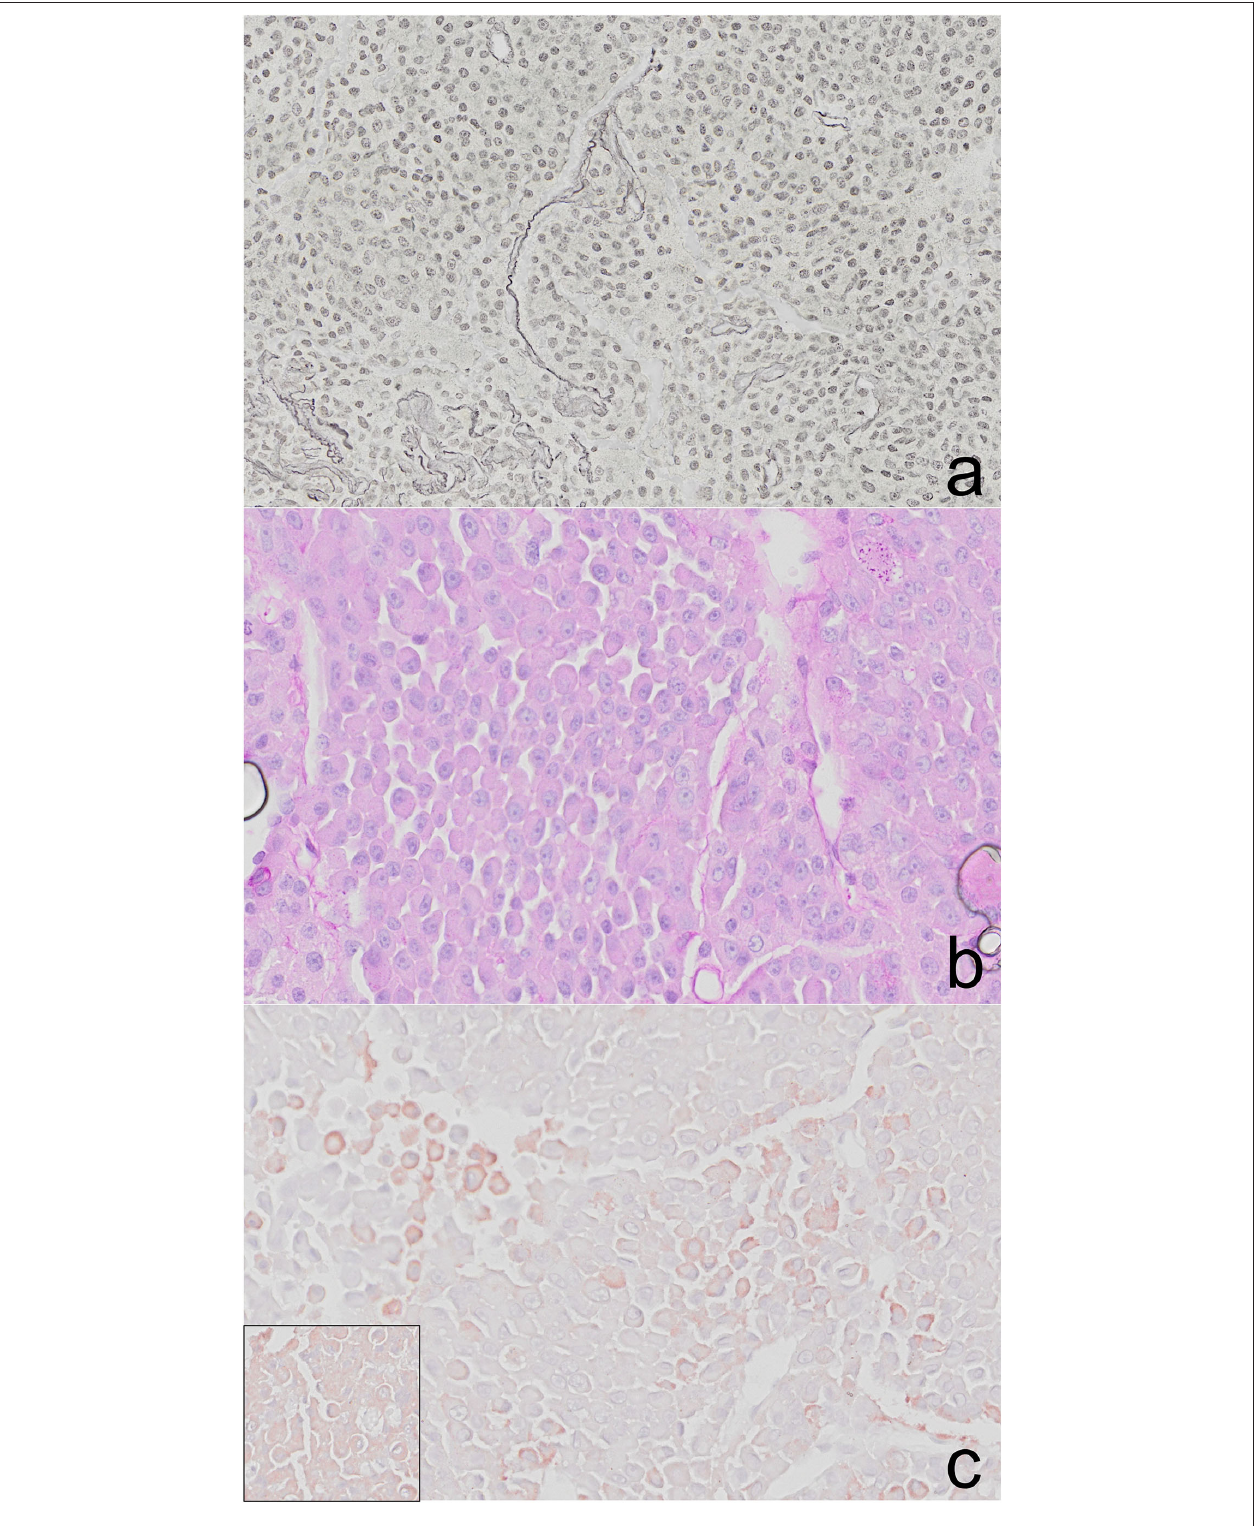
FIGURE 4 | Pituitary adenoma, cat. (a) The reticulin network is lost within the neoplasm and is still present in the compressed, peripheral pituitary tissue. (b) The cytoplasmic granules within the adenoma lack staining with PAS. (c) Clusters of cells throughout the adenoma have faint, cytoplasmic immunoreactivity to growth hormone (GH). GH positive control cells